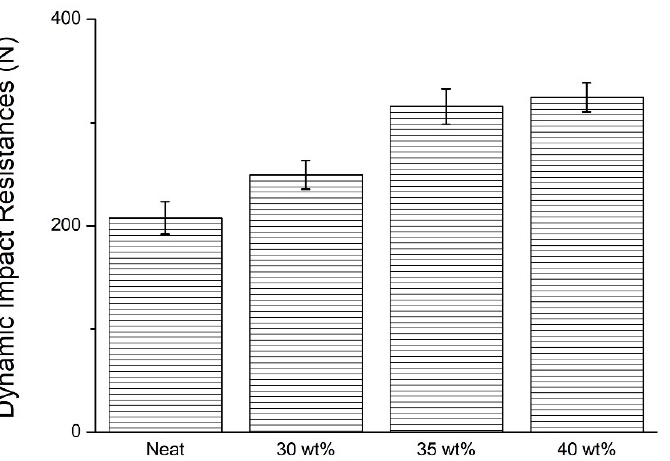
Figure 11. Dynamic impact strength of STF composite nonwoven fabrics as related to the STF concentration.